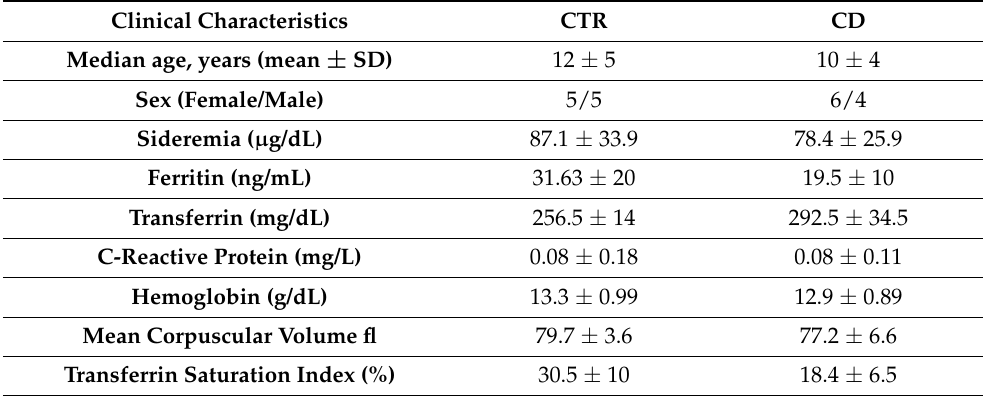
Table 1. Clinical characteristics of the controls (CTR) and celiac disease (CD)